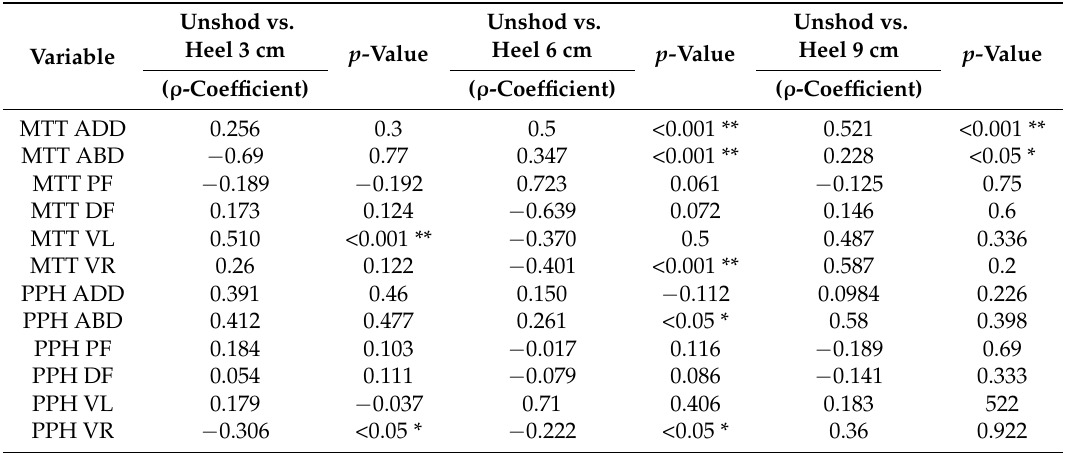
Table 6. STATIC Spearman-Rho correlation coefficients between variables.